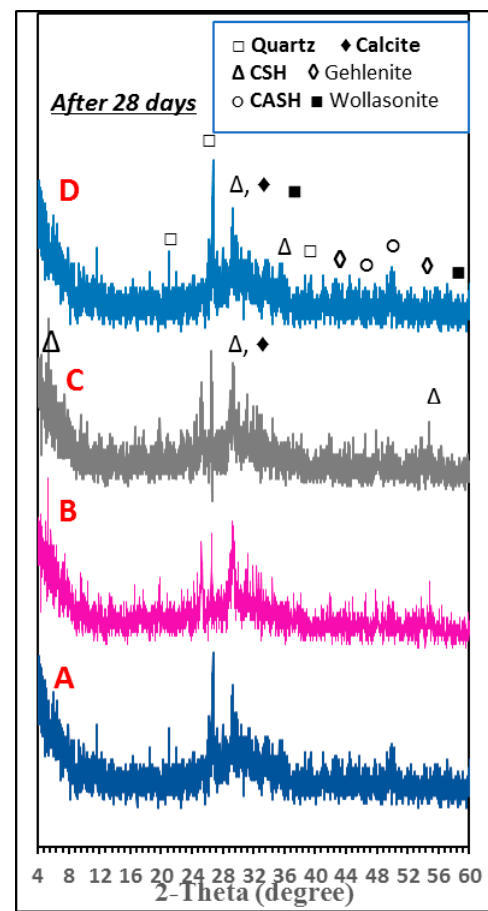
Figure 8. X-ray diffraction pattern of different geopolymer mixes under water curing for 7 and 28 days: ( A ) SF, ( B ) SF-RD, ( C ) SF-RD-Cu 2+ , ( D ) SF-Cu 2+ .